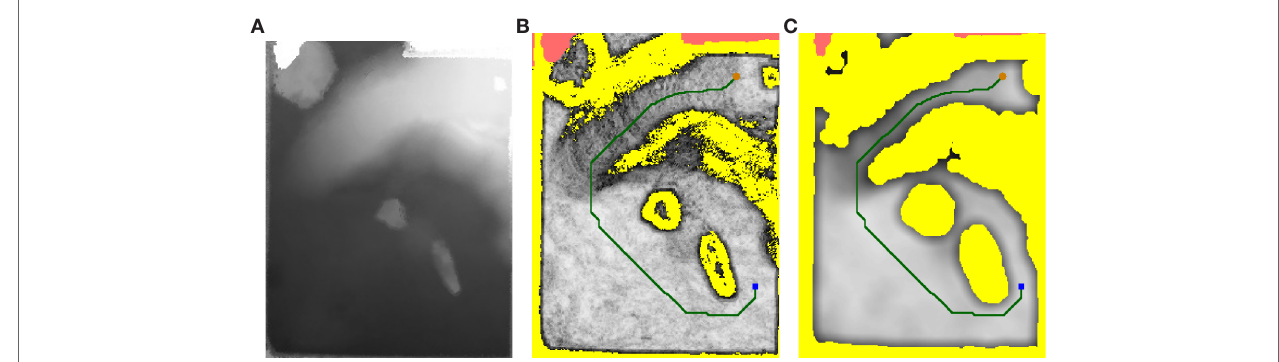
FIGURE 6 | Navigation planning . (A) 2.5D height map generated by projecting the 3D map. (B) Calculated traversability costs for each cell. (C) Inflated costs used for A* path planning. The orange dot represents the current robot position, the blue square represent the target position. Yellow regions represent absolute obstacles, red regions indicate missing